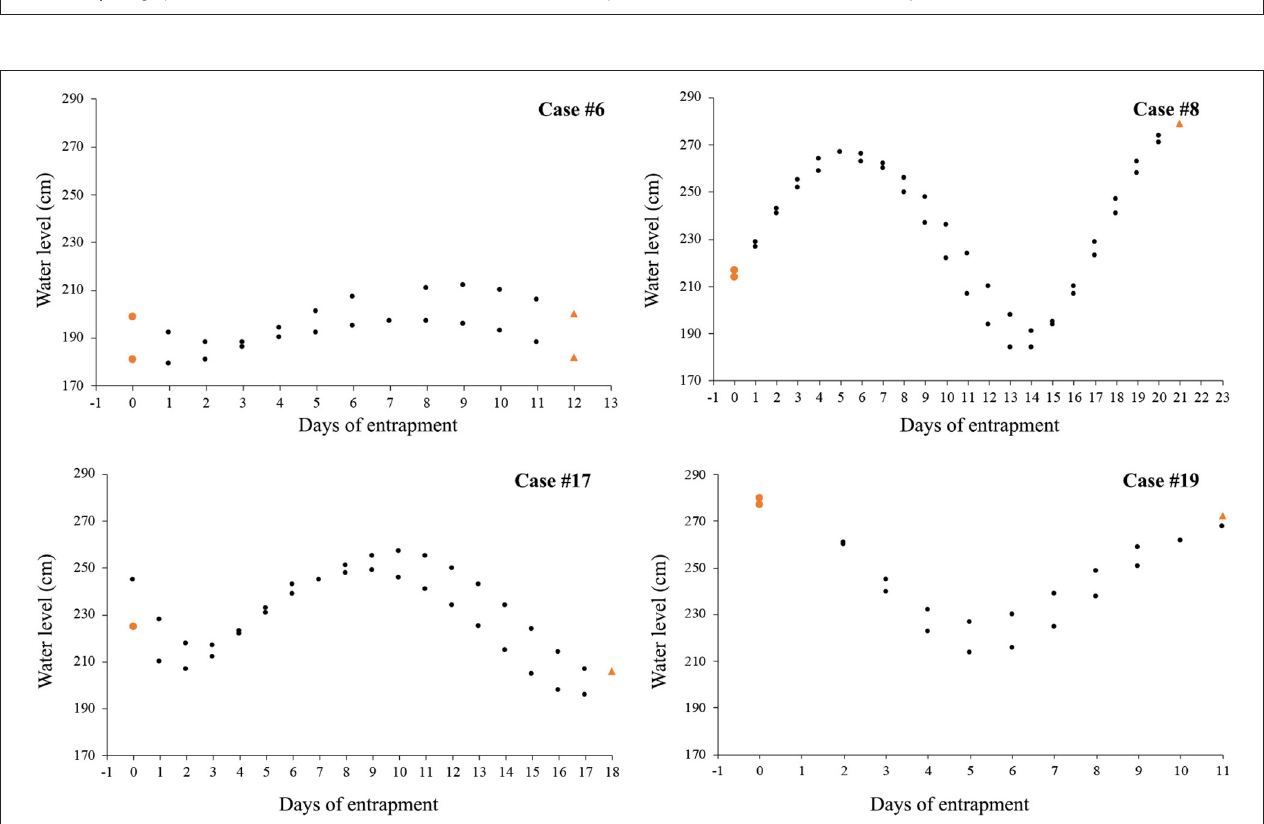
FIGURE 2 | Geographic distribution of the 19 cases of natural killer whale entrapments 1949–2019 included in this study.